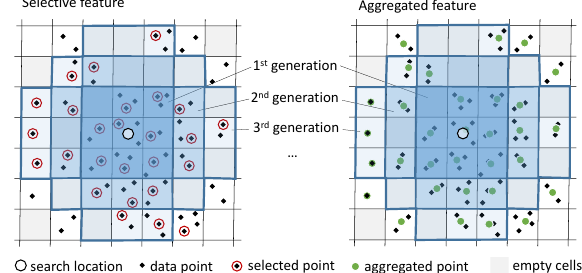
Figure 4. Sampling based on selective and aggregative features In general, spatial queries do not return the found points in a specific order, except for k NN. Since sorting points by their distance to the search point is an integral part of any k NN al- gorithm, the returned neighbours are always sorted according to the used dimension. Hence, for a 2D k NN query points will be sorted by the 2D distance and for the 3D case by 3D distances, respectively. If the processing algorithm requires a specific